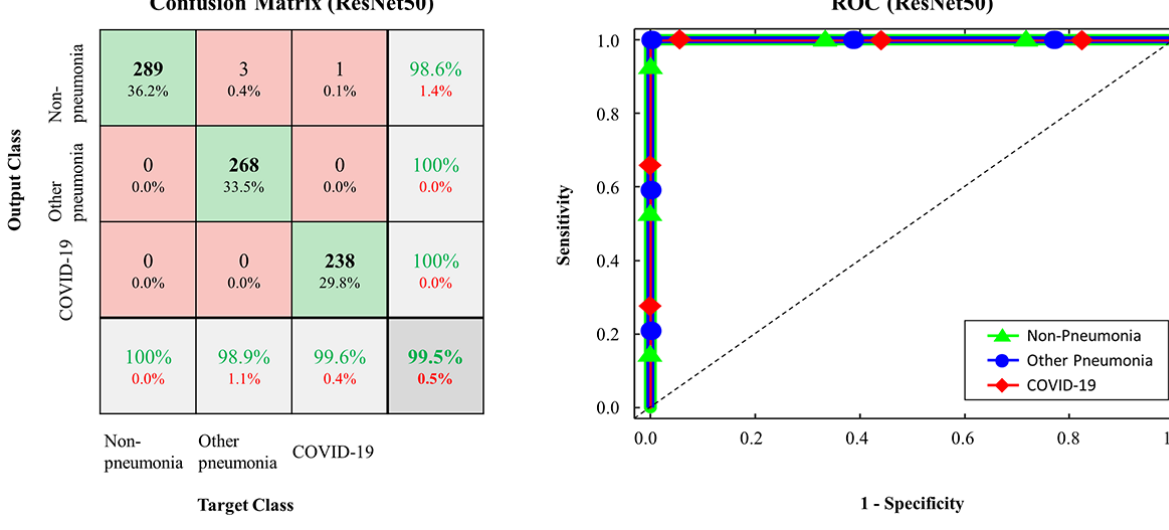
Figure 2. Confusion matrix and ROC curve in FCONet using ResNet-50; COVID-19: coronavirus disease; ROC: receiver operating